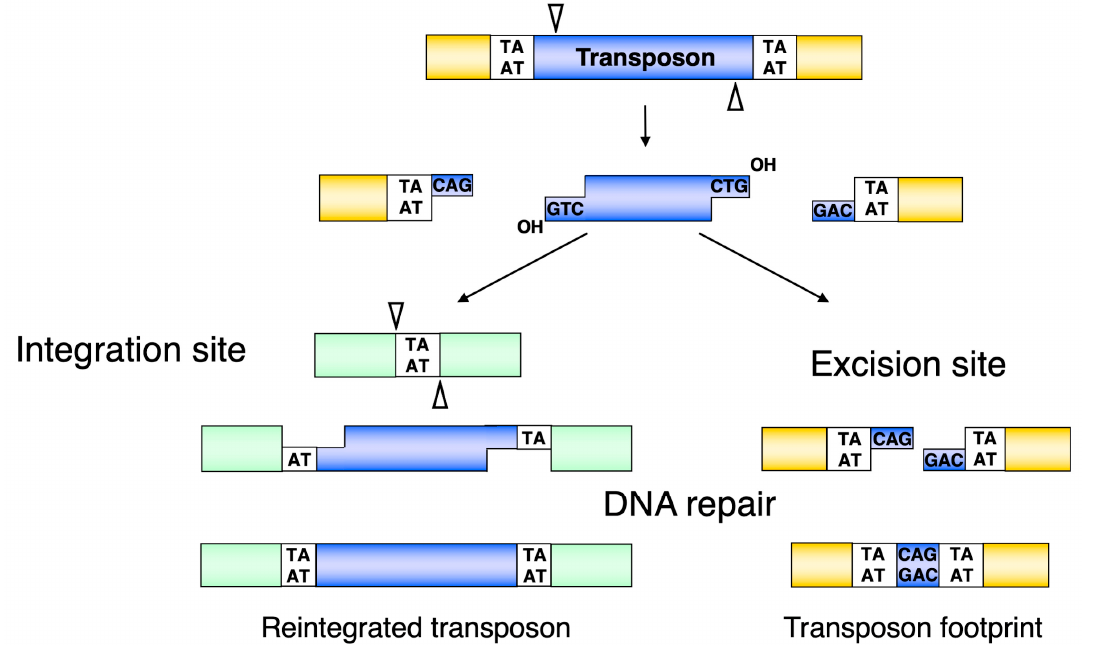
Figure 4. Molecular events leading towards the formation of transposon footprints and target site duplications in Sleeping Beauty transposition. The SB transposase excises the transposon with staggered cuts and reintegrates it at a TA target dinucleotide. The single-stranded gaps at the integration site and the double-strand DNA breaks at the donor DNA are repaired by the host DNA repair machinery. After repair, the target TA is duplicated at the integration site, and a small footprint is left behind at the site of excision. Reprinted from CMLS [64] with permission from the